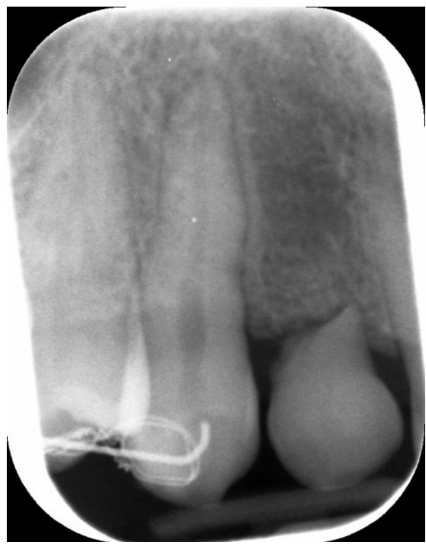
Figure 3. Periapical X-ray showing deciduous